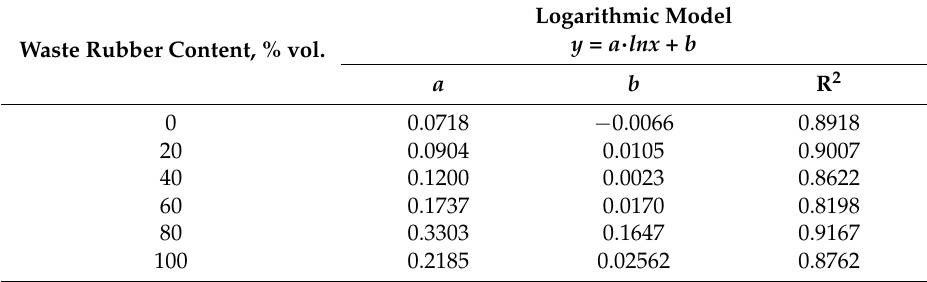
Table 4. Summary of coefficients of regression equations and coefficients of determination for mortars with different waste rubber content, obtained after 14 days exposure in water.